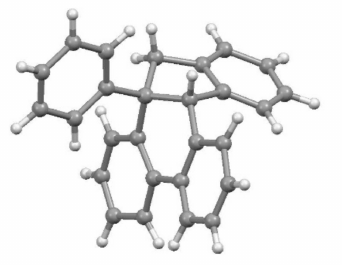
Figure 10. Structure of 13a-phenyl-13,13a-dihydro-8b H -indeno-[1,2- l ]-phenanthrene, 24